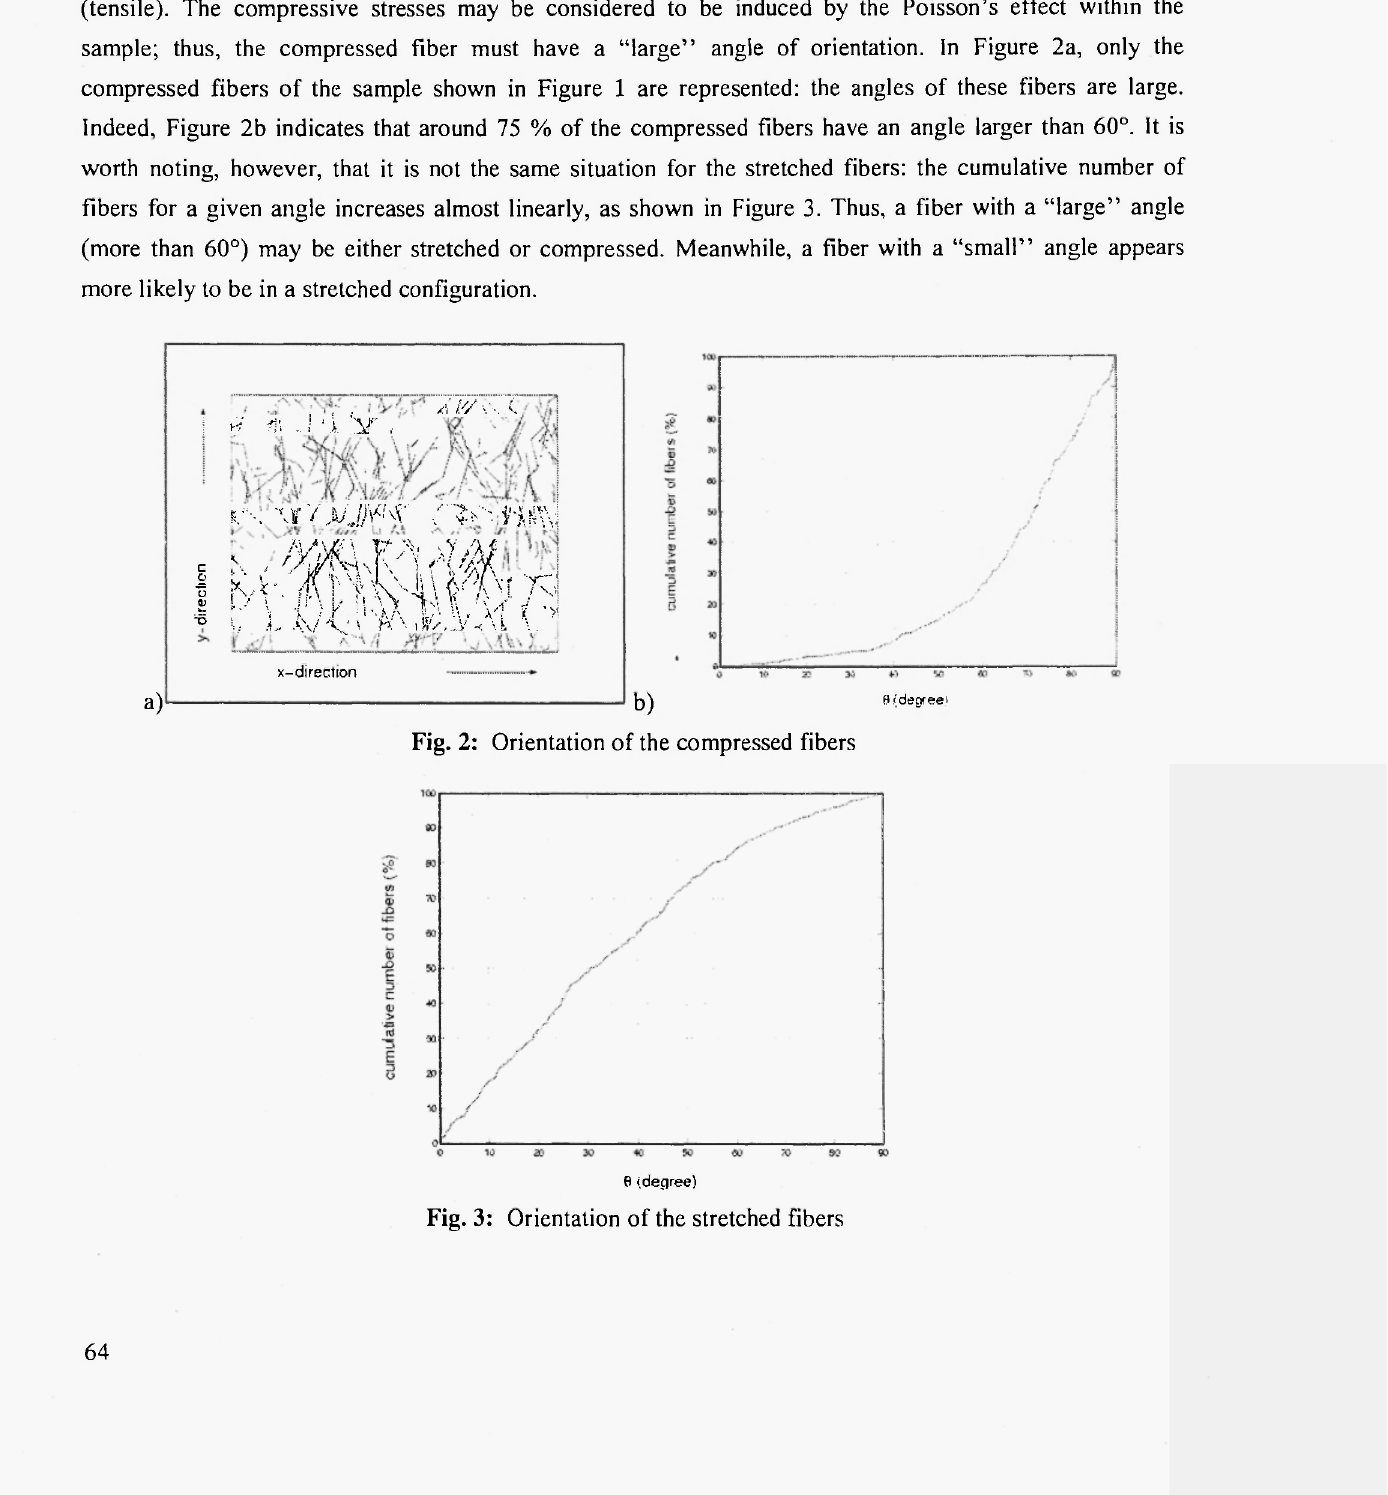
Fig. 2: Orientation of the compressed fibers